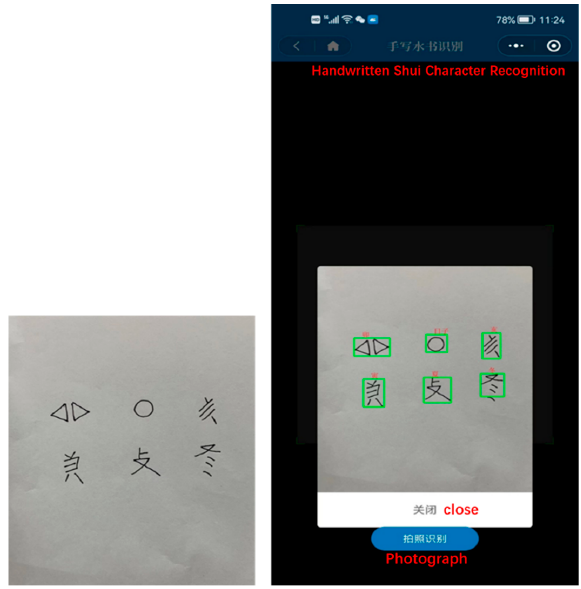
Figure 10. Application of Shui characters recognition module.( The red font in the picture is the